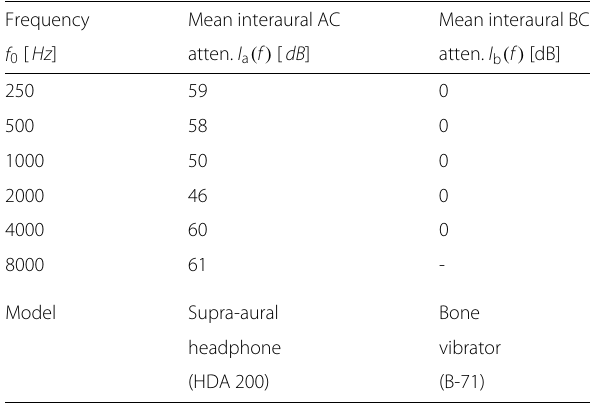
Table 1 Mean interaural attenuation at audiometric frequencies for AC and BC threshold audiometry according to [20] and [4],